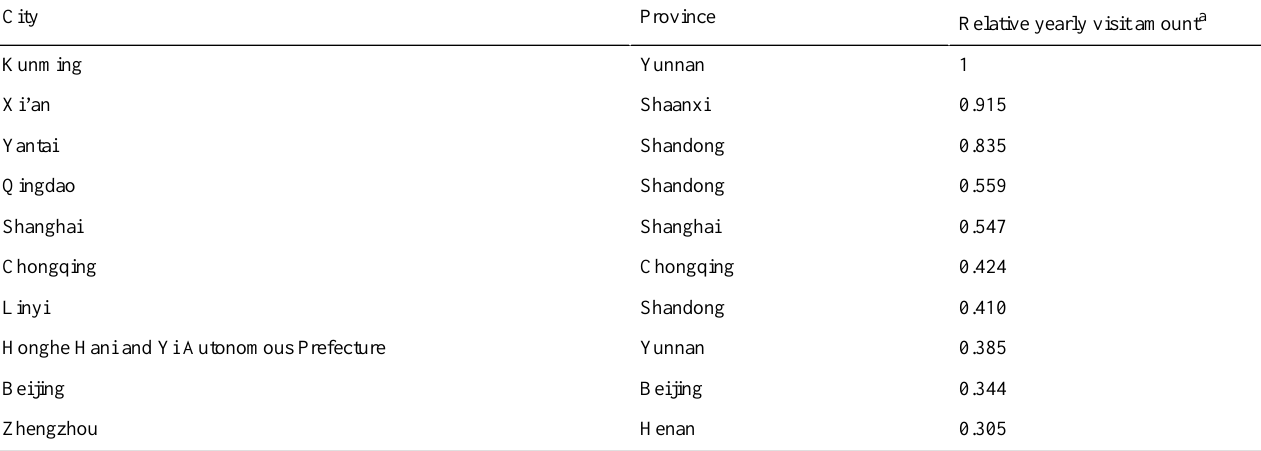
Table 3. Top 10 cities by visits to Ping An Good Doctor from August 2019 to August 2020.